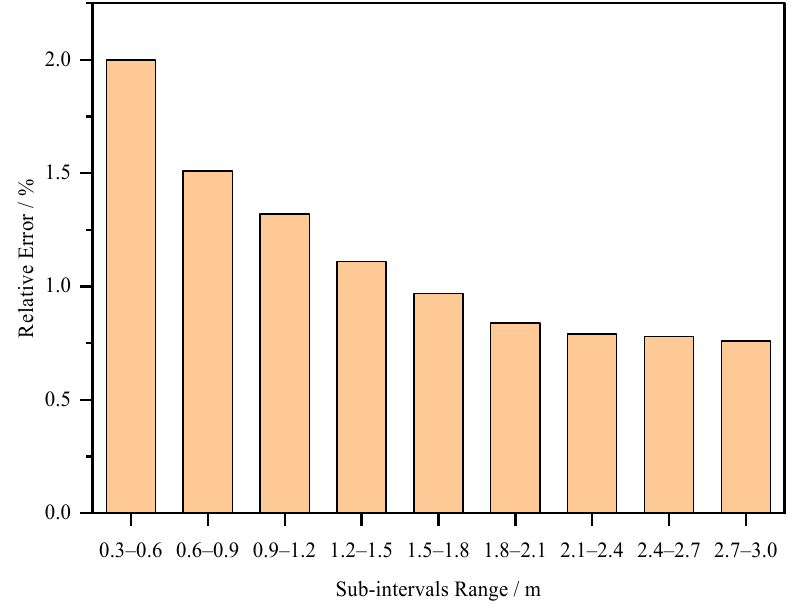
Figure 11. Relative error of distance estimation in different sub-intervals.